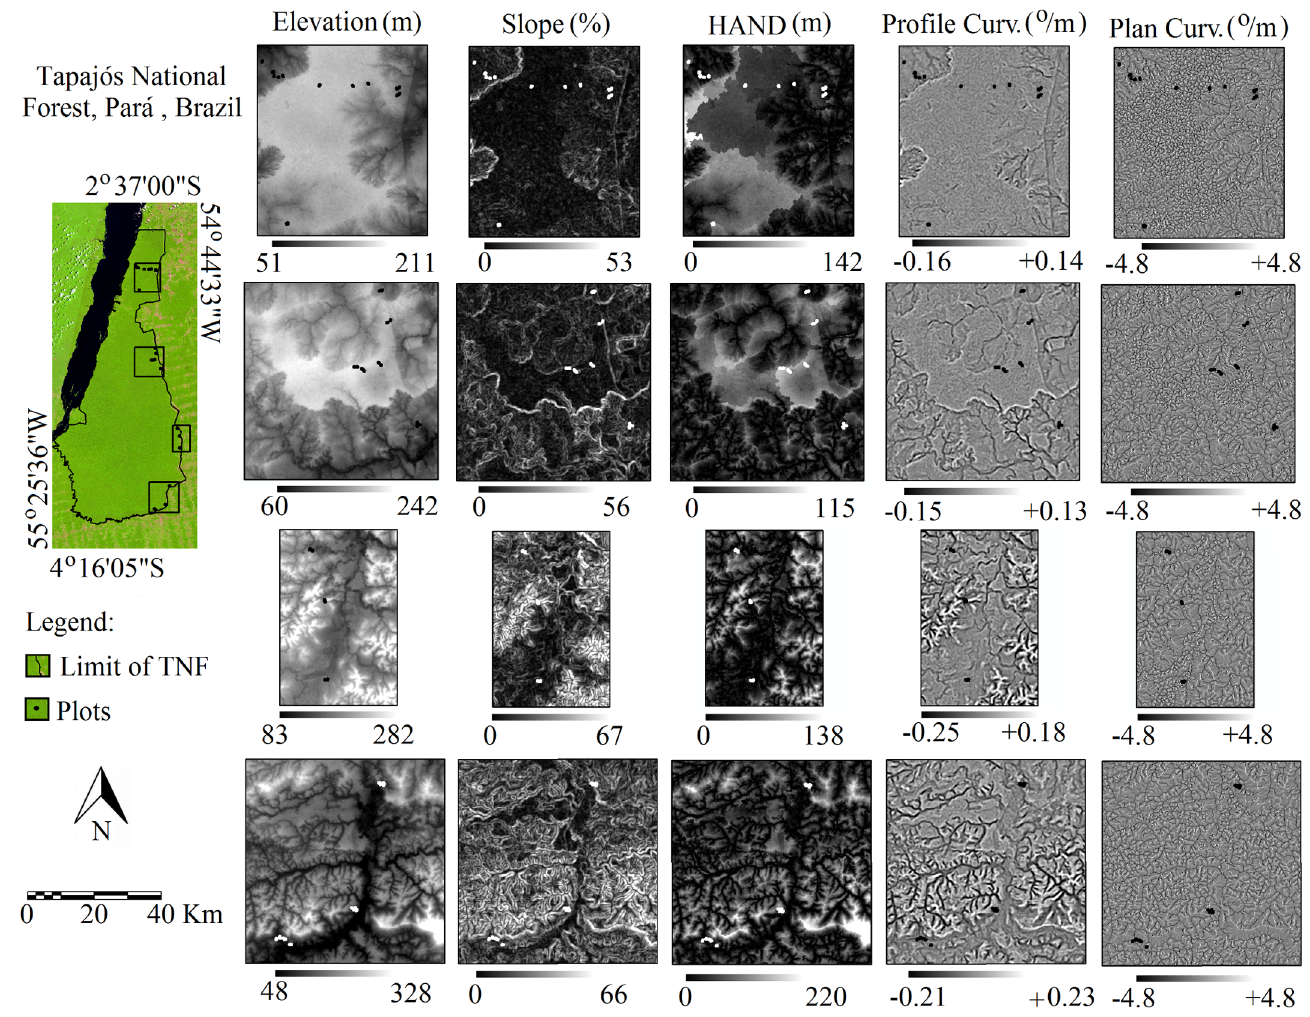
Fig 1. Study area in the Tapajo´s National Forest (TNF), Para´ State, Brazil, with details of the five geomorphometric variables (elevation, slope, HAND, profile curvature and plan curvature)of the four areaswhere the 46 plots were distributed.